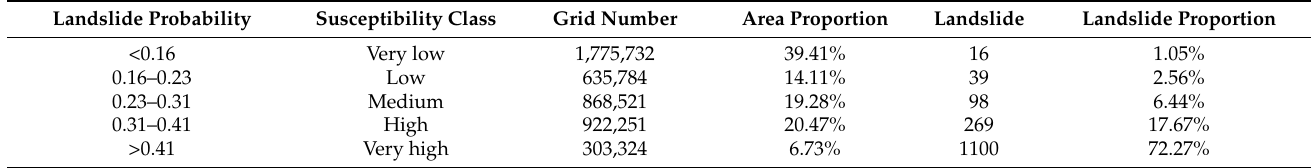
Table 6. Statistical results for landslide comprehensive susceptibility in different classes.